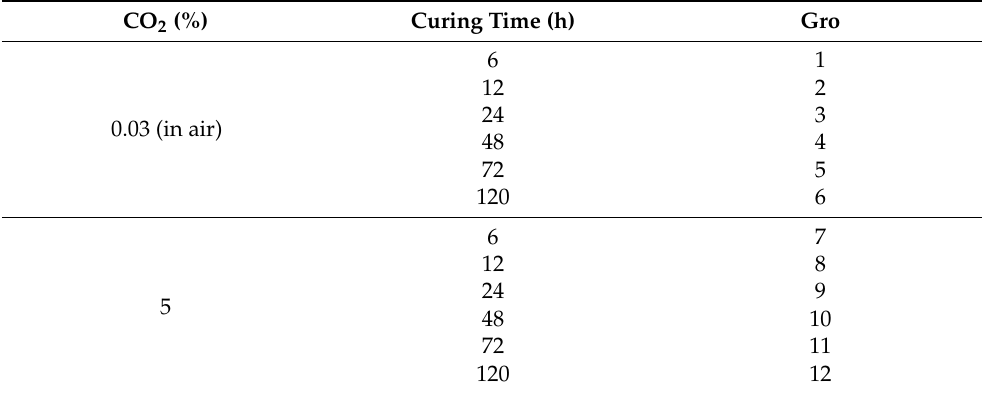
Table 2. Different Conservation Environments of the City Wall Restoration Soil.